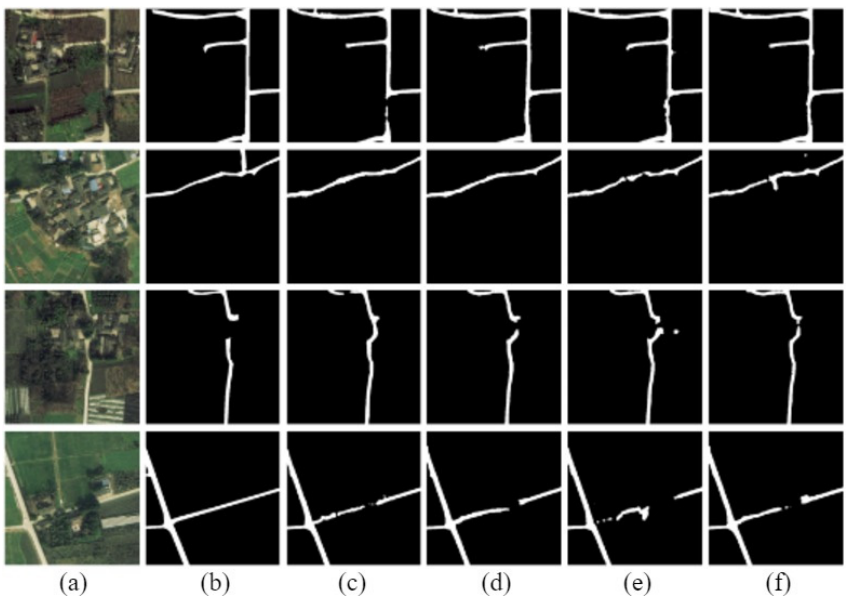
Figure 16. Comparison results of complex scene experiment. ( a ) input image; ( b ) label image; ( c ) D-LinkNet_50; ( d ) D-LinkNet_101; ( e ) B-D-LinkNetPlus_50; and ( f ) B-D-LinkNetPlus_101.